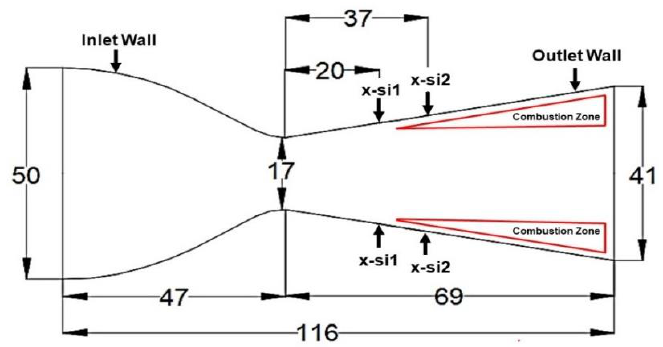
Figure 2. Geometric parameters of gas generator nozzle with secondary injection positions, whereas x-si1 and x-si2 are secondary injection positions (dimensions in mm).